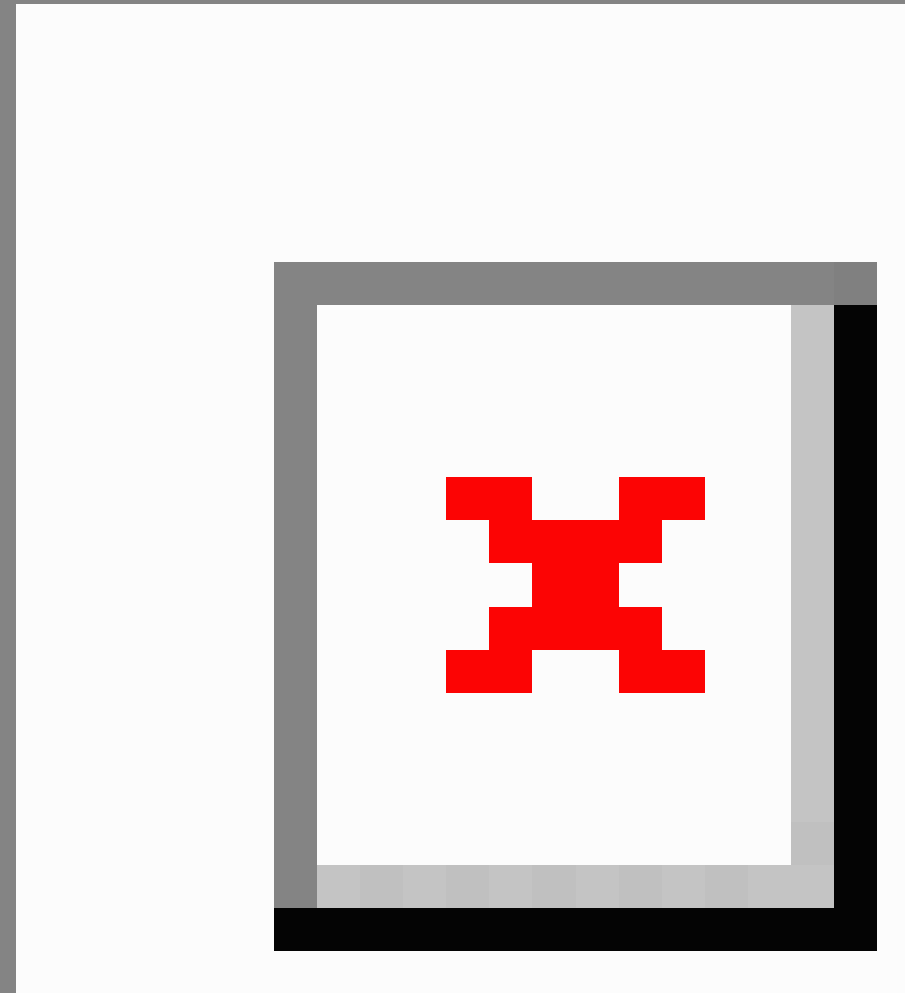
Figure 2. Example of a potential violation of patient